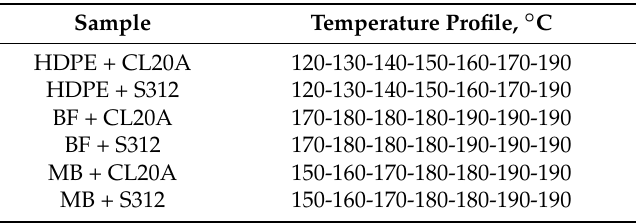
Table 2. Processing conditions in the twin-screw extruder.